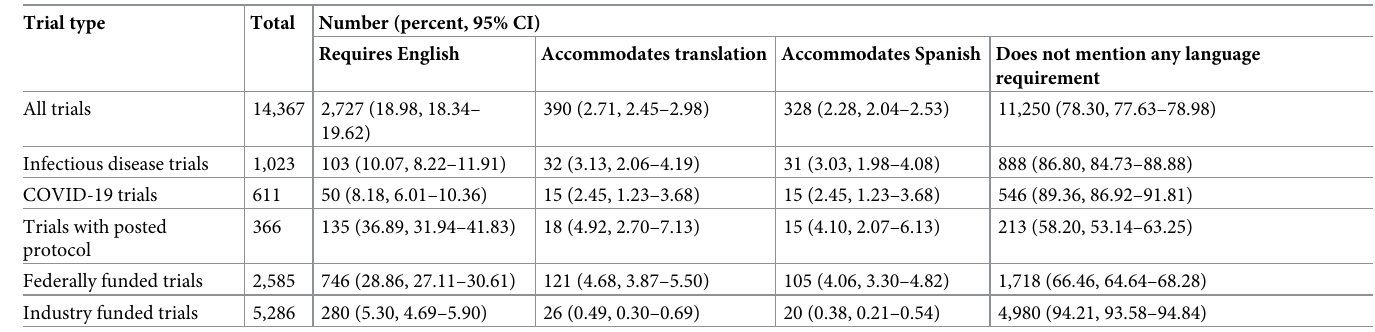
Table 2. Language requirements in clinical